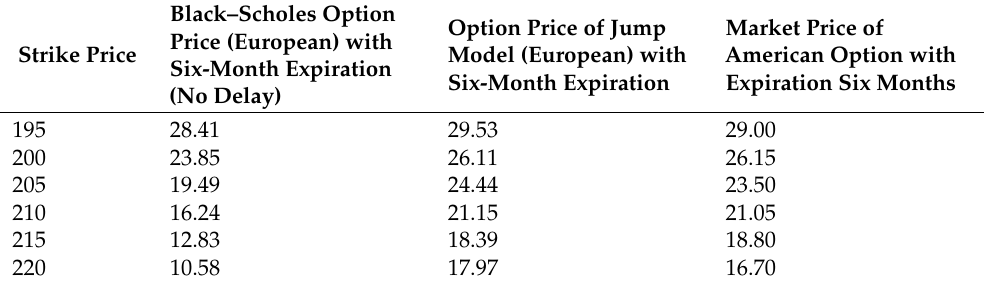
Table 3. Call option price comparison for T = 6 months for Microsoft